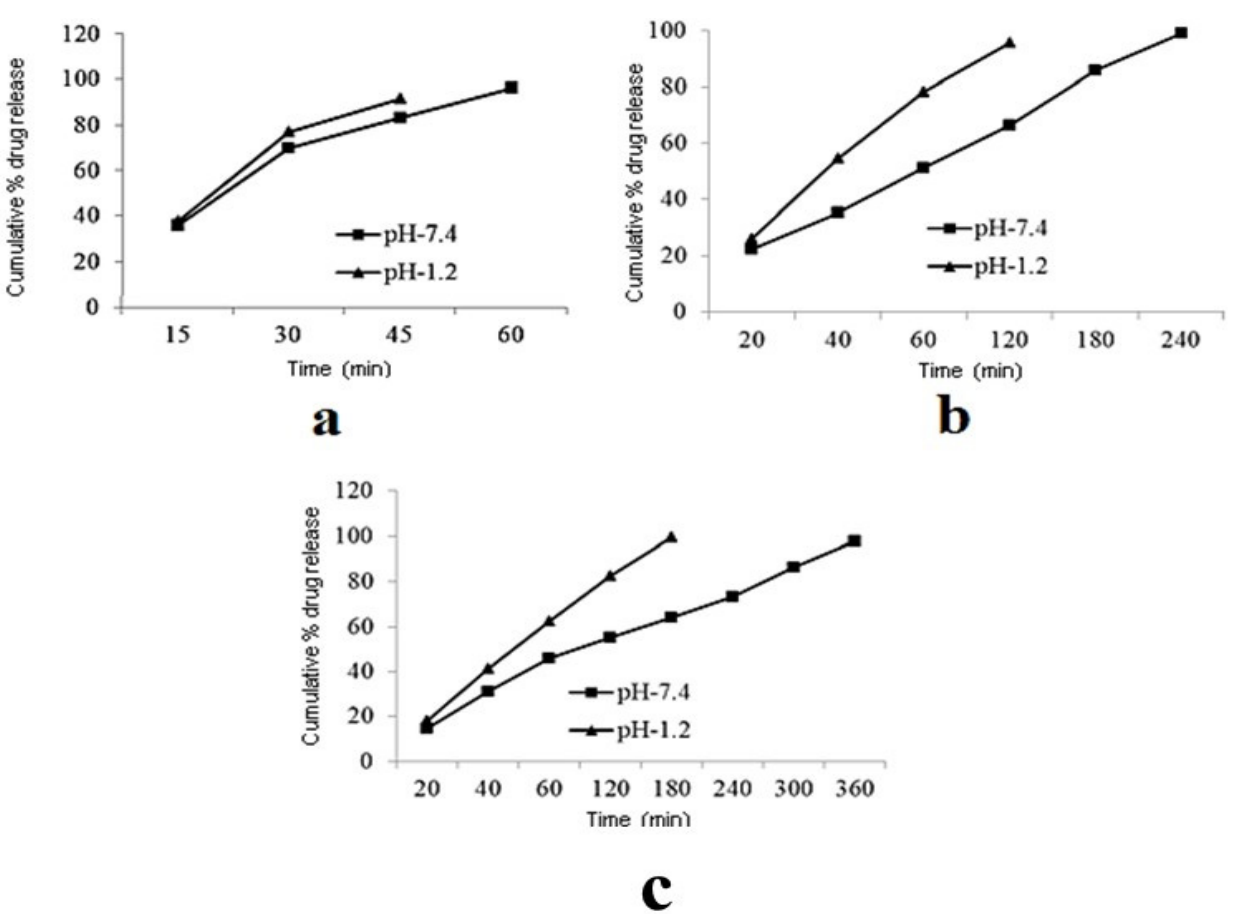
Figure 26. Influence of concentration on the cumulative percentage of drug delivery at ( a ) 0.05%, ( b ) 0.1%, and ( c ) 0.15% of capoten-loaded nanocomposite hydrogels. Reproduced with permission from [322].